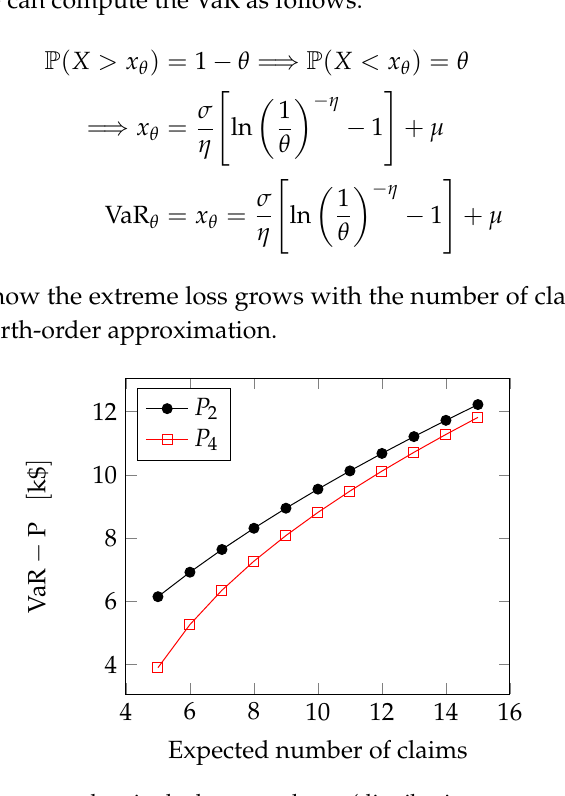
Figure 6. Insurer’s extreme loss in the lognormal case (distribution parameters as in Table 5).